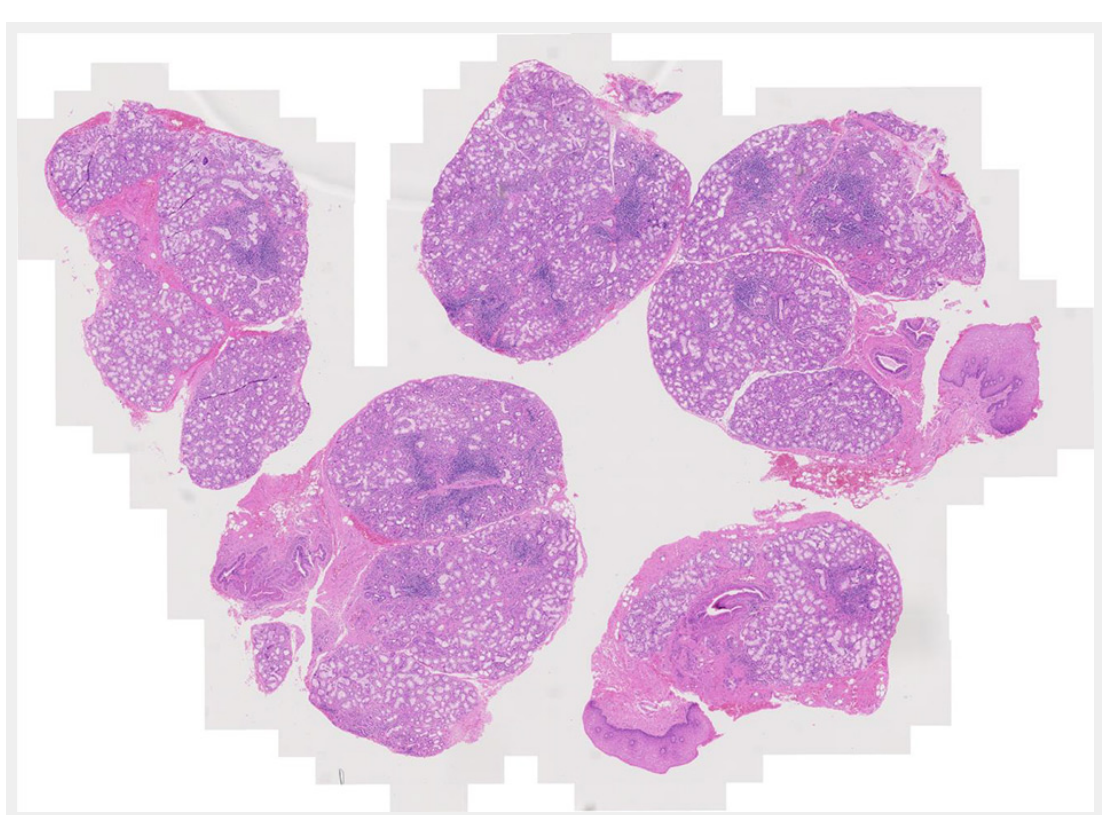
Figure 1 Haematoxylin and eosin staining of salivary gland biopsy section showing several periepithelial mononuclear cell infiltrates, i.e. focal lymphocytic